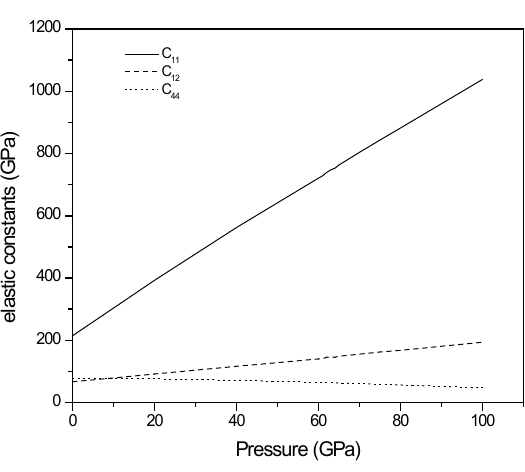
Figure 5. Variation of elastic constants with pressure at T=300 K. Fig. 5